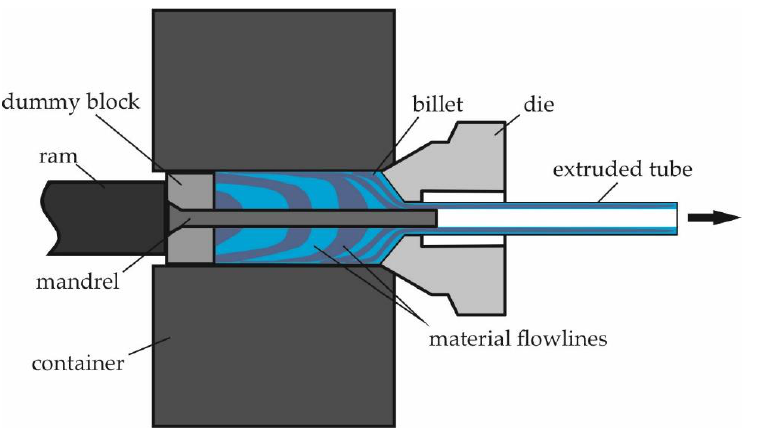
Figure 1. Schematic of the extrusion process of the Al tubes with the estimated material flow based on Ostermann [10]. nal diameters D i , being 12 mm and 16 mm, resulting in extrusion ratios Ψ of 13:1 and 22:1, respectively. This resulted in wall thicknesses t of 4 mm and 2 mm, and, thus, the ratio t/D o of wall thickness to outer diameter was 20% and 10%, respectively.